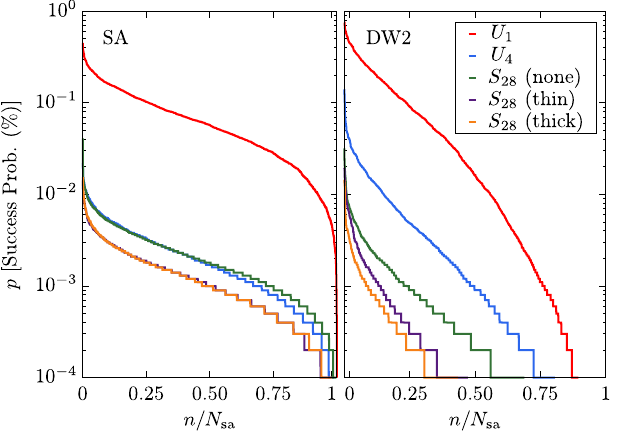
FIG. 2. Sorted success probabilities p (after a gauge average) in percent SA (left) and the DW2 device (right) and different instance classes. The instance index n is normalized by the number of instances N per class for better viewing. For both sa cases, bimodal disorder ( U 1 ) is the easiest problem class to solve.